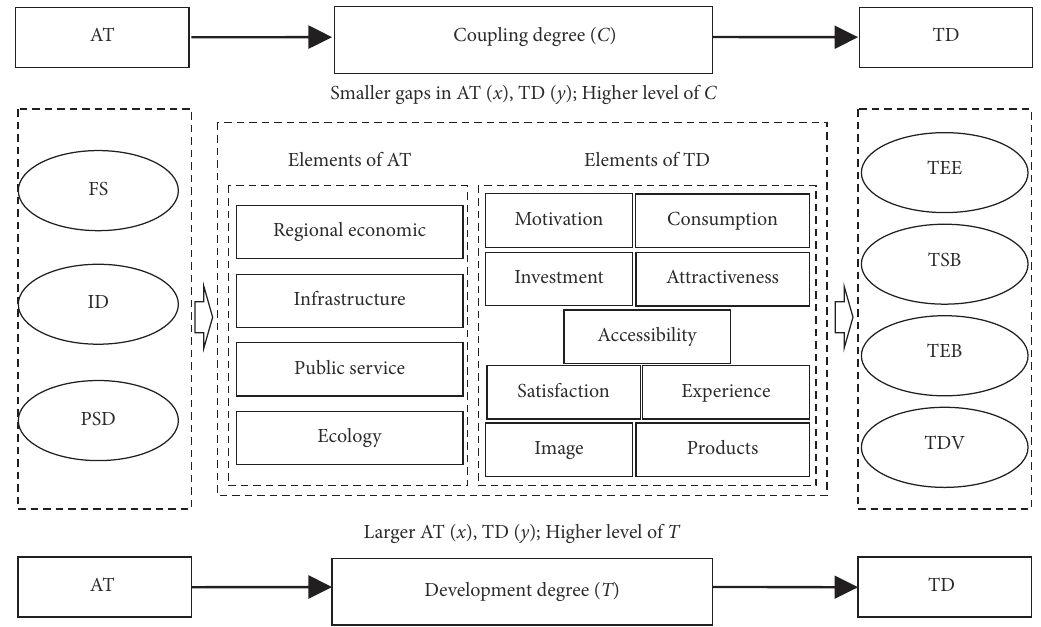
Figure 7: Dynamics of the coordinated development of AT and